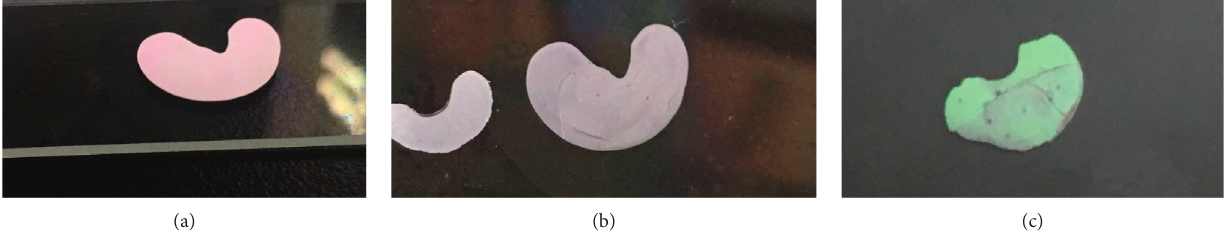
Figure 4: Photographs of SiO 2 self-assembling (a), PEGDA/SiO 2 (b), and the IOPCs